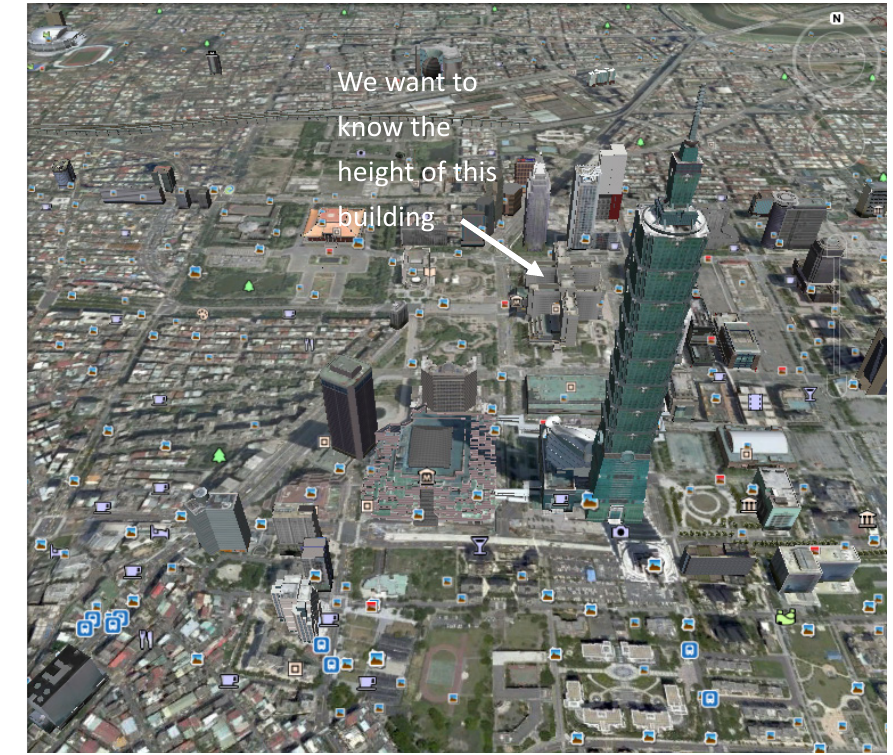
Figure A1. Open Google Earth for locating the building.